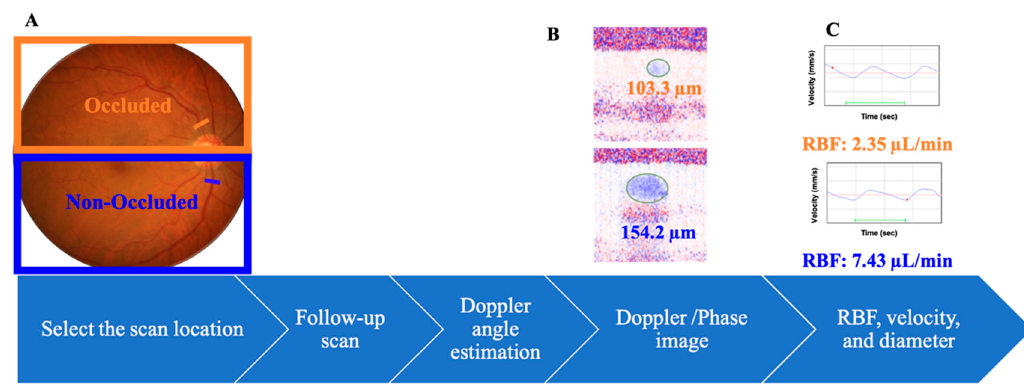
Figure 1. Flow of the image used to measure the retinal blood flow on a Doppler optical coherence tomography flowmeter. ( A ) Color fundus photograph. The bar indicates the measured location on occluded (orange) and non-occluded (blue) veins. ( B ) Phase images with color coding showing the blood flow signals of the vessels on the occluded (orange bar) and non-occluded (blue bar) veins. The numbers indicate the vessel diameter ( µ m). ( C ) Retinal blood flow (RBF) velocity profiles of the retinal veins within 2 s measured by a Doppler optical coherence tomography (DOCT) flowmeter on the occluded (superior) and non-occluded (inferior) veins; the colored numbers indicate the averaged blood velocity (orange: occluded vein; blue: non-occluded vein).